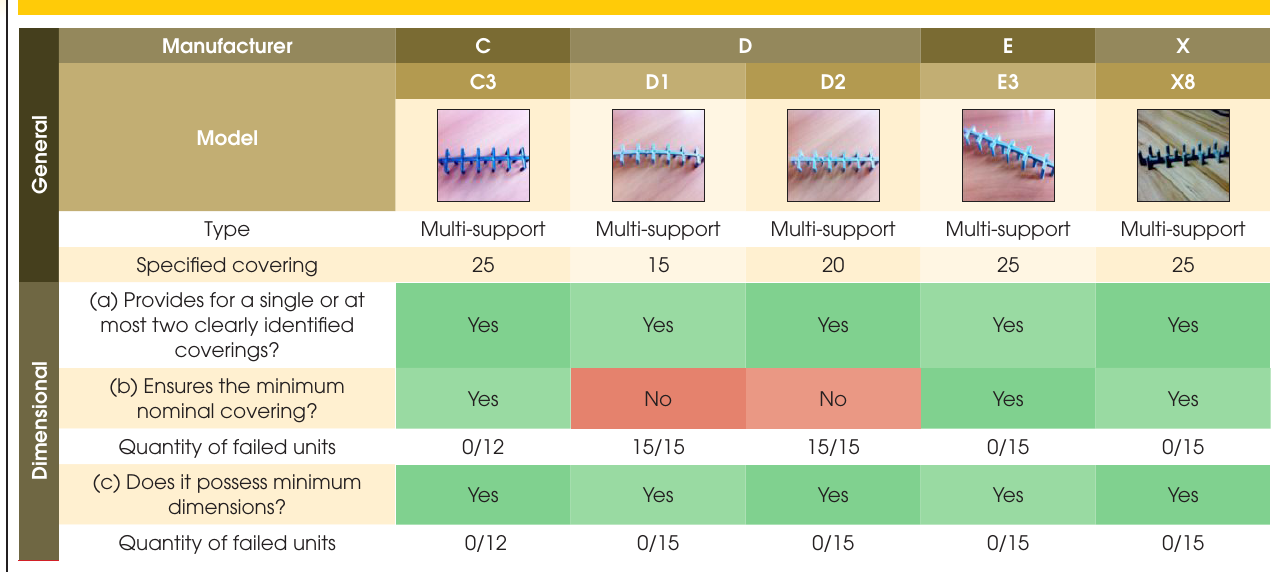
Table 7 – Results of the design requirement evaluation of the multi-support-type